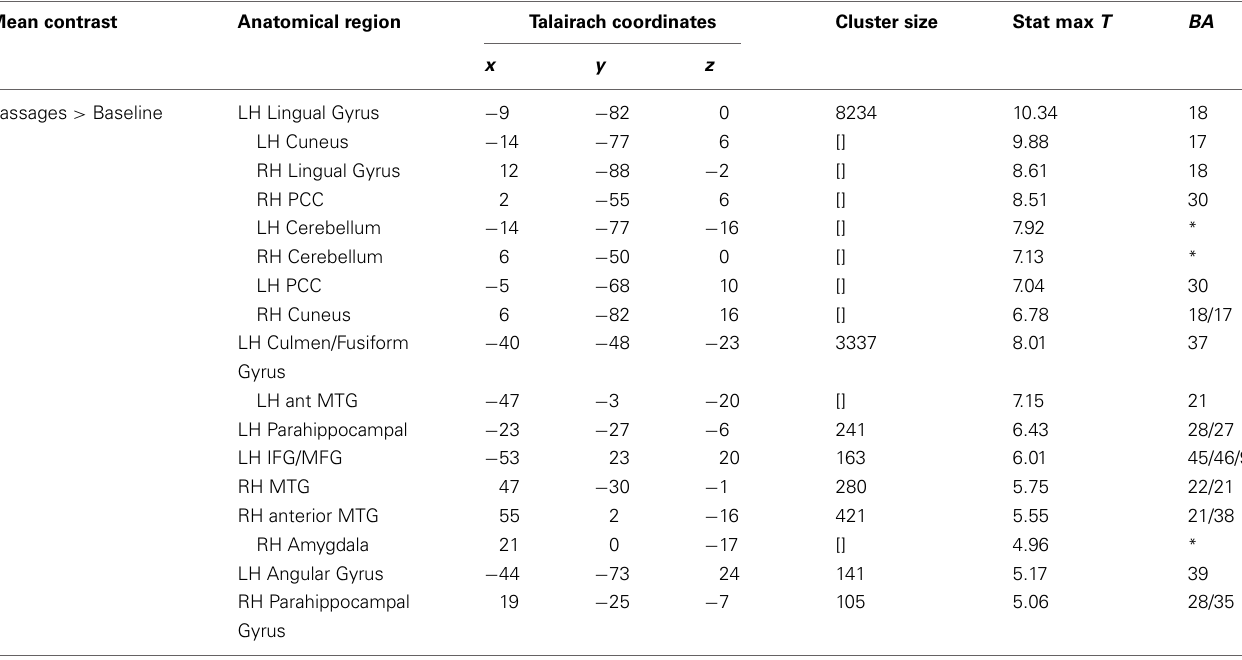
Table 2 | Passages vs. Baseline mean analysis. Mean contrast Anatomical